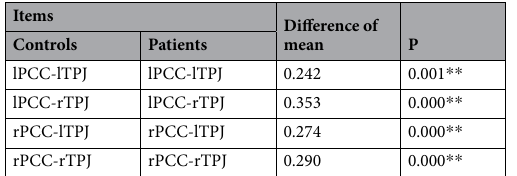
Table 2. Significant T-test with Bonferroni multiple-comparison correction Results of PCC-TPJ Patterns between Patients and Controls. T-test with Bonferroni multiple-comparison correction: SE = 0.058. ** α = 0.01; * α = 0.05.